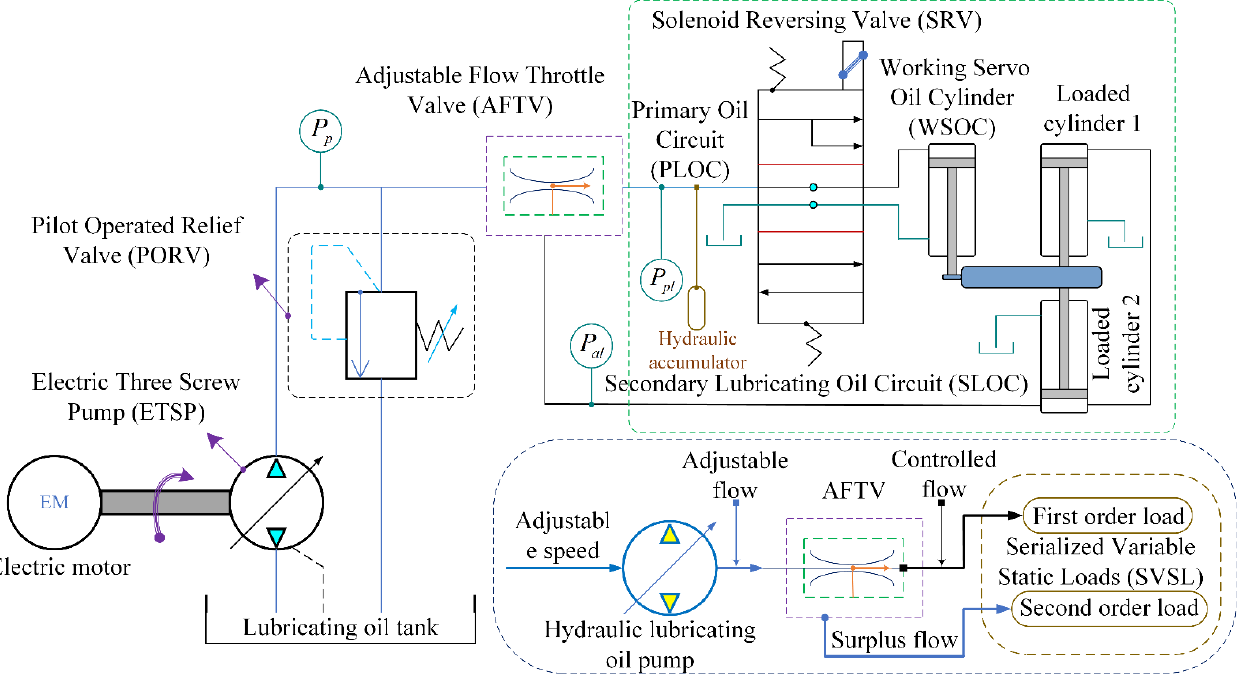
Figure 1. Schematic diagram of a non ‐ closed ‐ loop hydraulic system with AFTV and PORV.